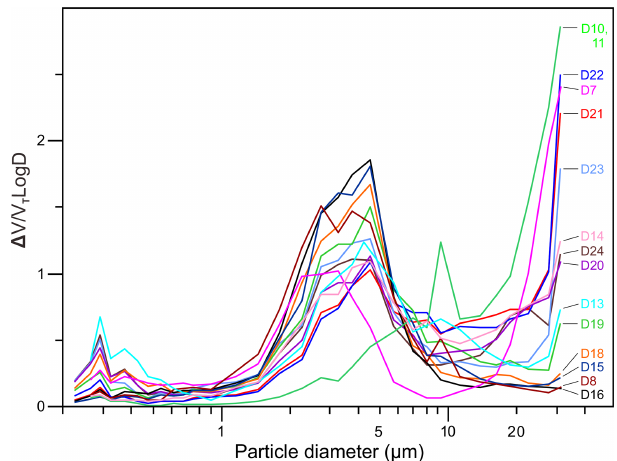
Figure 2. Volume size distributions of aerosols during the Asian dust events, as measured by an optical particle counter located at the nearest Korea Meteorological Administration (KMA) monitor- ing stations. See Table 1 for the sampling site and time during the dust